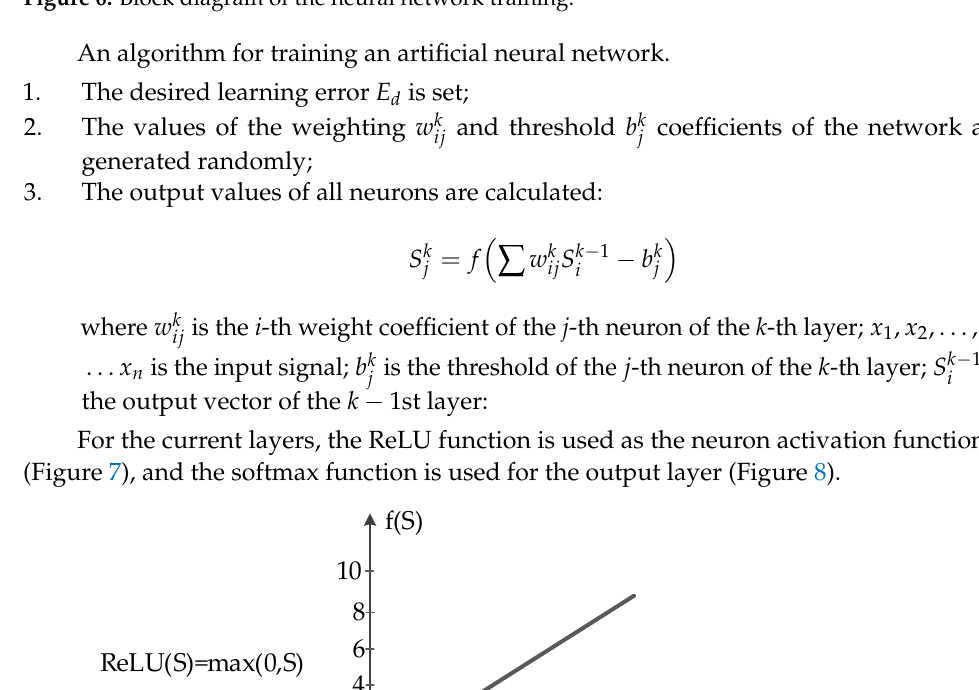
Figure 6. Block diagram of the neural network training.